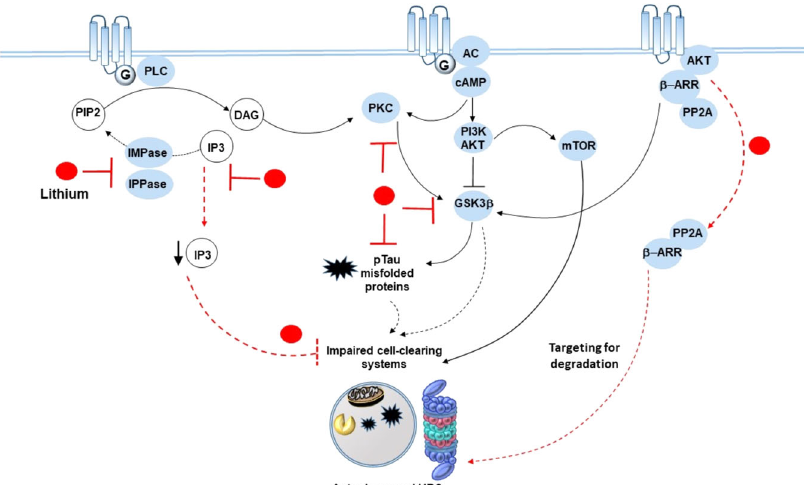
Fig. 2 Lithium, amphetamine-related sensitization, and cell-clearing systems. Lithium inhibits IMPase and IPPase, as well as PKC and GSK3 β , which are triggered downstream of dopamine GPCRs. This results in reduced production and phospho-tau/misfolded proteins and the rescue of cell-clearing systems, which are impaired by mTOR hyperactivation placed downstream of D1 DA receptors and/or by abnormal amounts of phospho-tau. At the same time, lithium disassembles the GSK3- β -activating proteins β -ARR and PP2A from the complex they form with GPCRs/AKT meanwhile targeting them for degradation by the cell-clearing systems. In this way, lithium adjusts dopamine imbalances that occur following psychostimulant intake/administration and abnormal activation of GPCRs and related downstream signaling pathways.